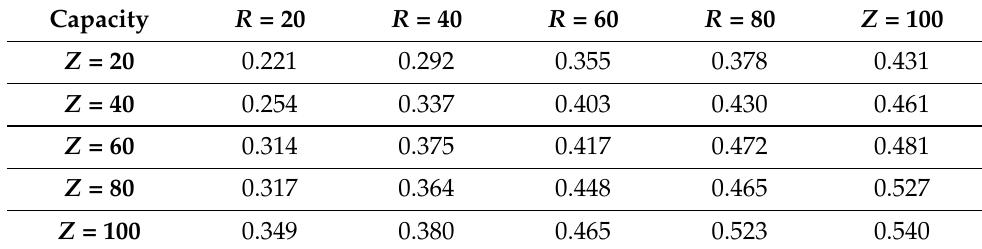
Table 4. Accuracy@10 with different #topic and